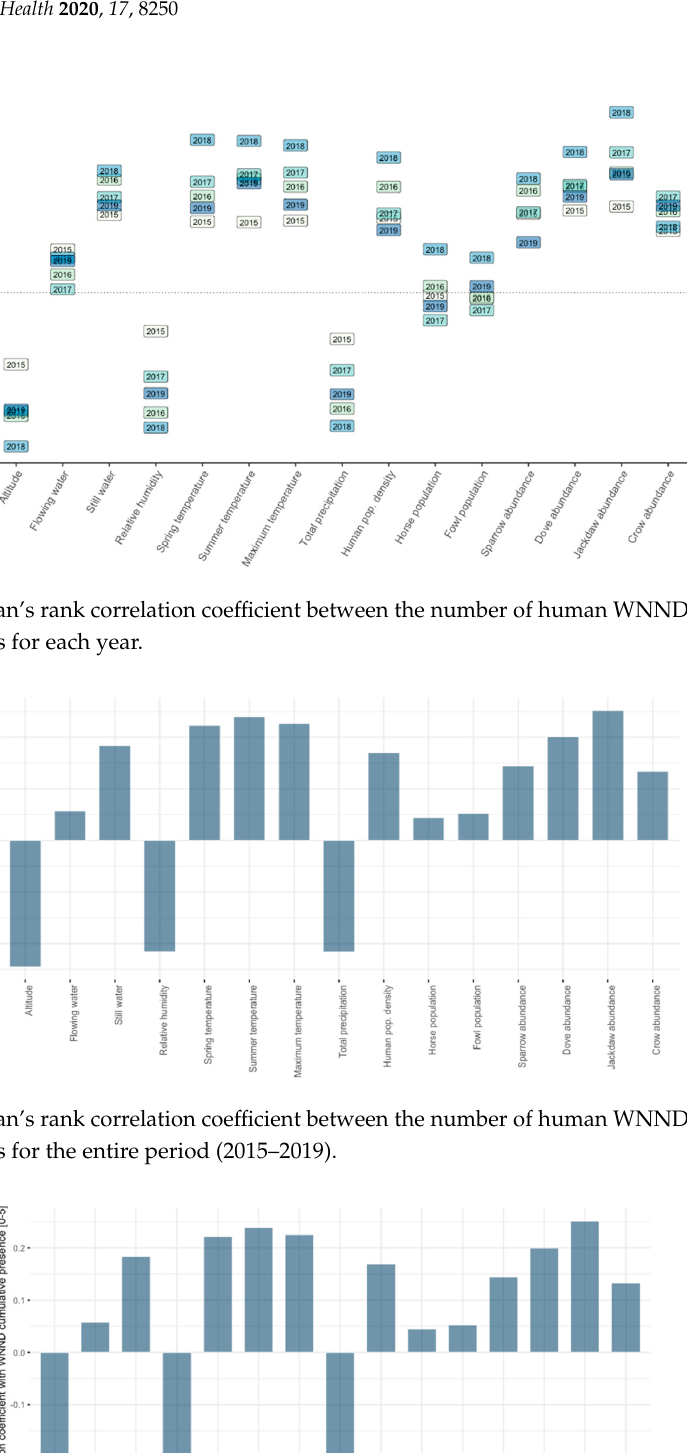
Table 2. Spearman’s rank correlation coefficient between the number of years with human WNND cases (0–5) and the number of human cases for each year.